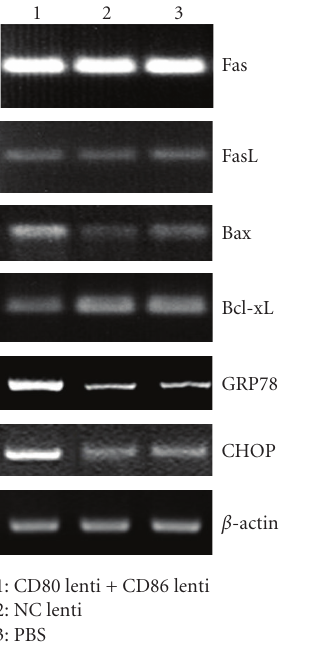
Figure 7: T cells isolated on day 5 after translation from the spleens of C3H recipients bearing B6 heart allografts treated with PBS or recombinant lentivirus transduced DCs were used for analysis of T cell apoptosis signaling pathway molecules by RT-PCR. All data are representative of three separate